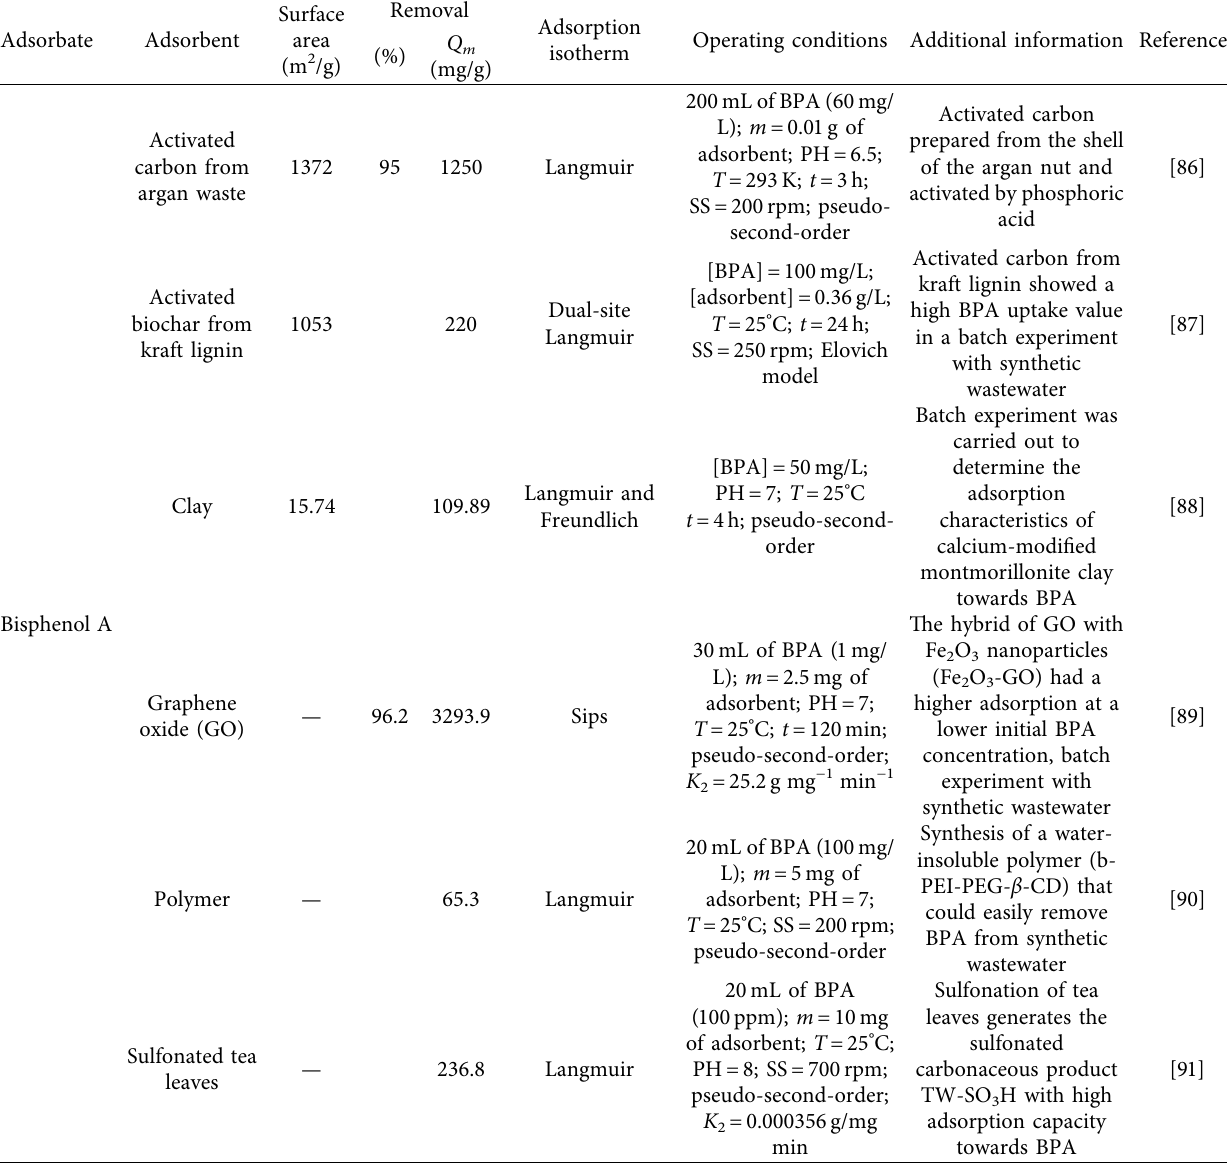
Table 3: Removal efficiency, isotherms, and kinetic parameters for the removal of the studied emerging pollutants by different adsorbents.